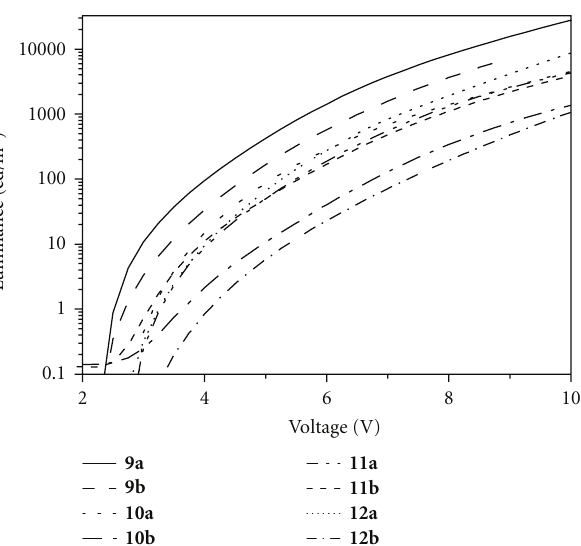
Figure 12: General OLED stack.